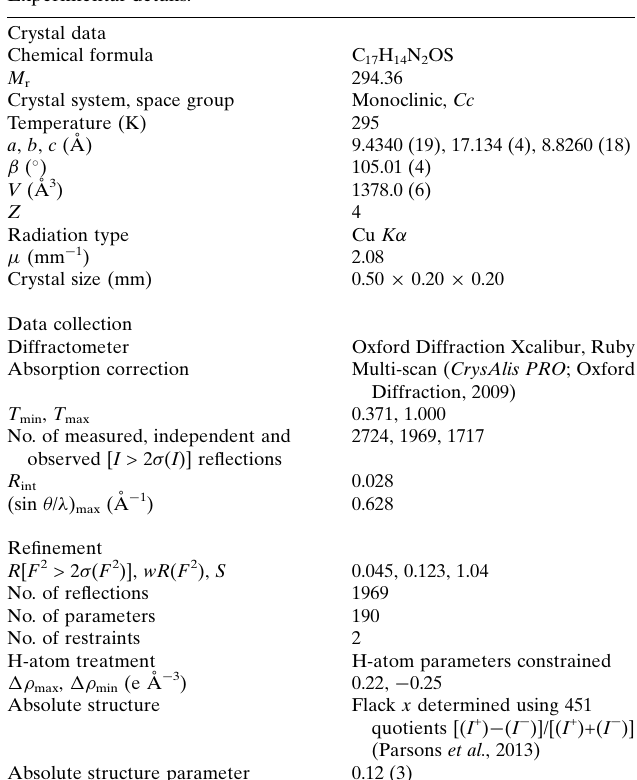
Table 2 Experimental details.